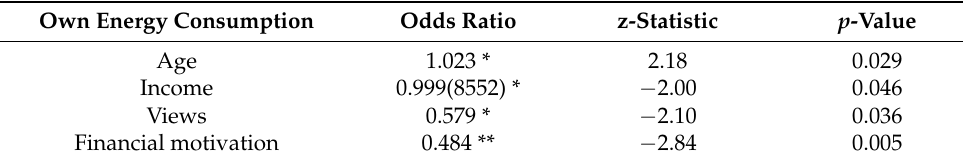
Table 7. Logistic regression: paying attention to own energy